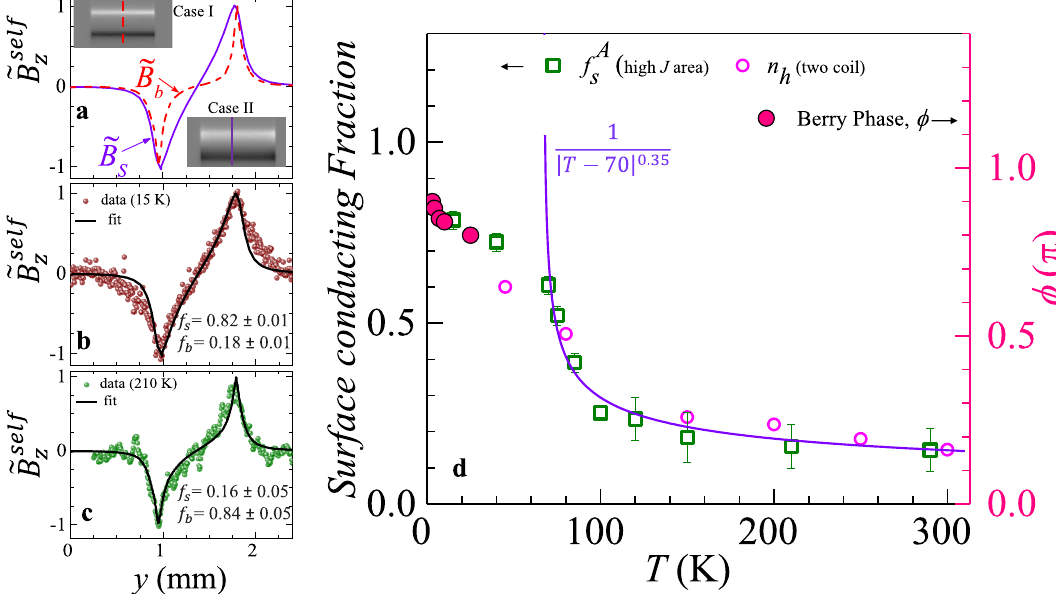
Figure 4. Analysis of self-magnetic field profile and fraction of surface contribution of electrical conductivity. self ( a ) Figure shows the simulated magnetic field profiles ˜ B z ( y ) for bulk (case I) and surface (case II) currents distributed in the crystal. Upper and lower panels show as grey scale images, the simulated self-field distribution self across the crystal, for the case I and II. Figures ( b ) and ( c ) show the behaviour of measured ˜ B z ( y ) and the Eq. 1 self φ fit to the measured ˜ B π ) versus temperature z ( y ) data at 15 K, and 210 K, respectively. ( d ) The Berry phase ( (pink filled circles) calculated from the SdH oscillation observed on the magneto-resistance measurements on (cid:31) the crystal (see section II of supplementary) is shown on the right vertical axis. The green square symbol shows the area fraction of the high current density region ( f A s ) as a function of temperature (see text for details). Circle symbols represents the fraction of high conducting surface state ( n h ) measured as a function of temperature, determined using the two-coil mutual inductance technique (reproduced from Fig. 5(a) of Ref. 28 ). The violet 1 solid line is the functional form of | T − 70 | 0.35 ± 0.02 (cid:31) self , y ) distribution for (case I) and 2D surface sheet current (case II), respectively. Figure 4a com- simulated B z ( x